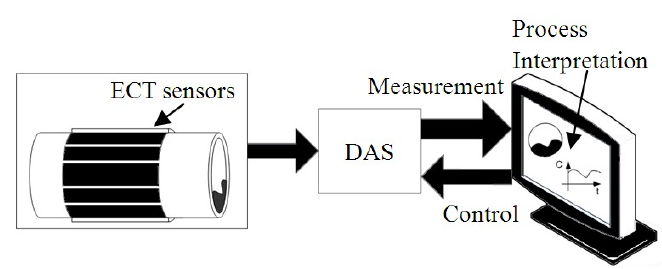
Figure 1. Schematic diagram of an ECT system.